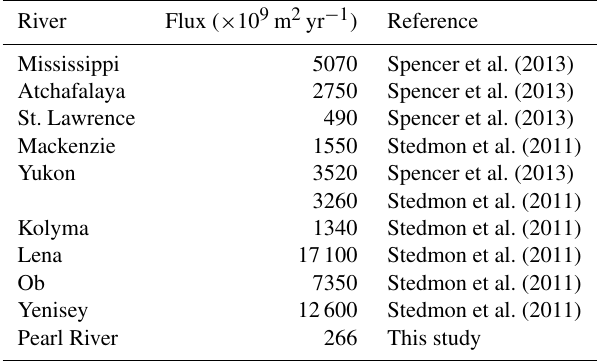
Table 3. DOC concentrations and CDOM abundances ( a 330 ) in ma- jor world rivers.